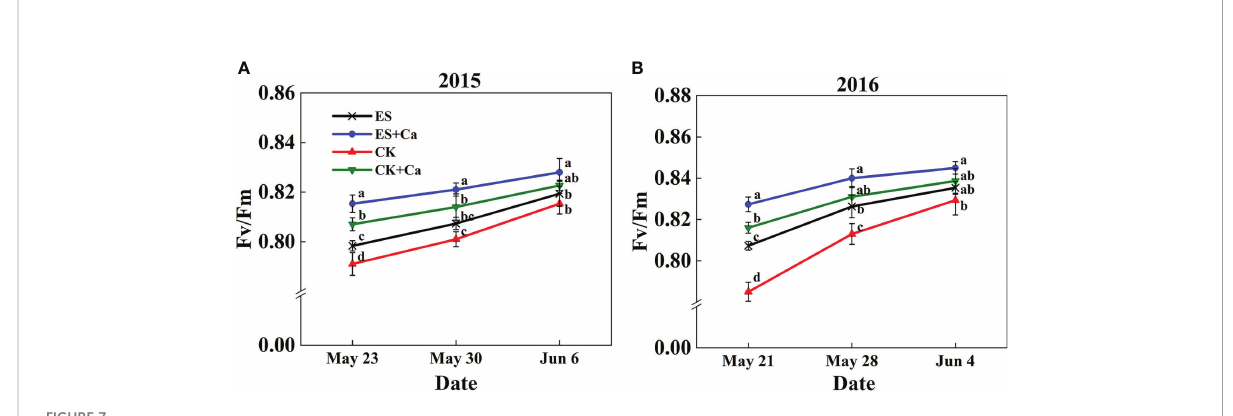
FIGURE 7 Effects of exogenous foliar calcium (Ca 2+ ) application on peanut maximum quantum yield of PSII (Fv/Fm) under early and normal sowing scenarios during the (A) 2015 and (B) 2016. Values are means ± SD (n = 3). Different letters indicate signi fi cant differences according to Duncan ’ s multiple range tests ( p <